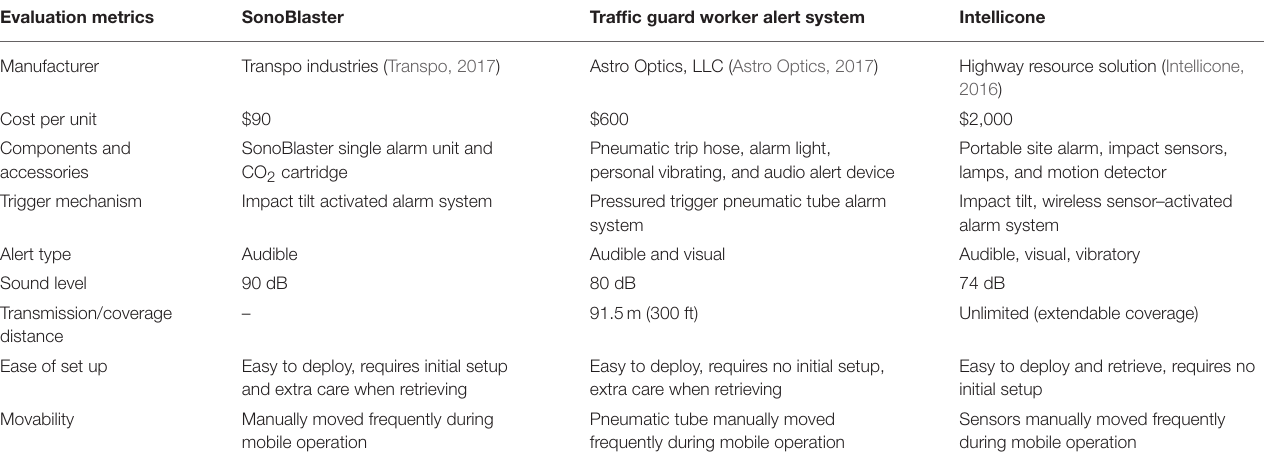
TABLE 2 | Evaluation of work zone intrusion